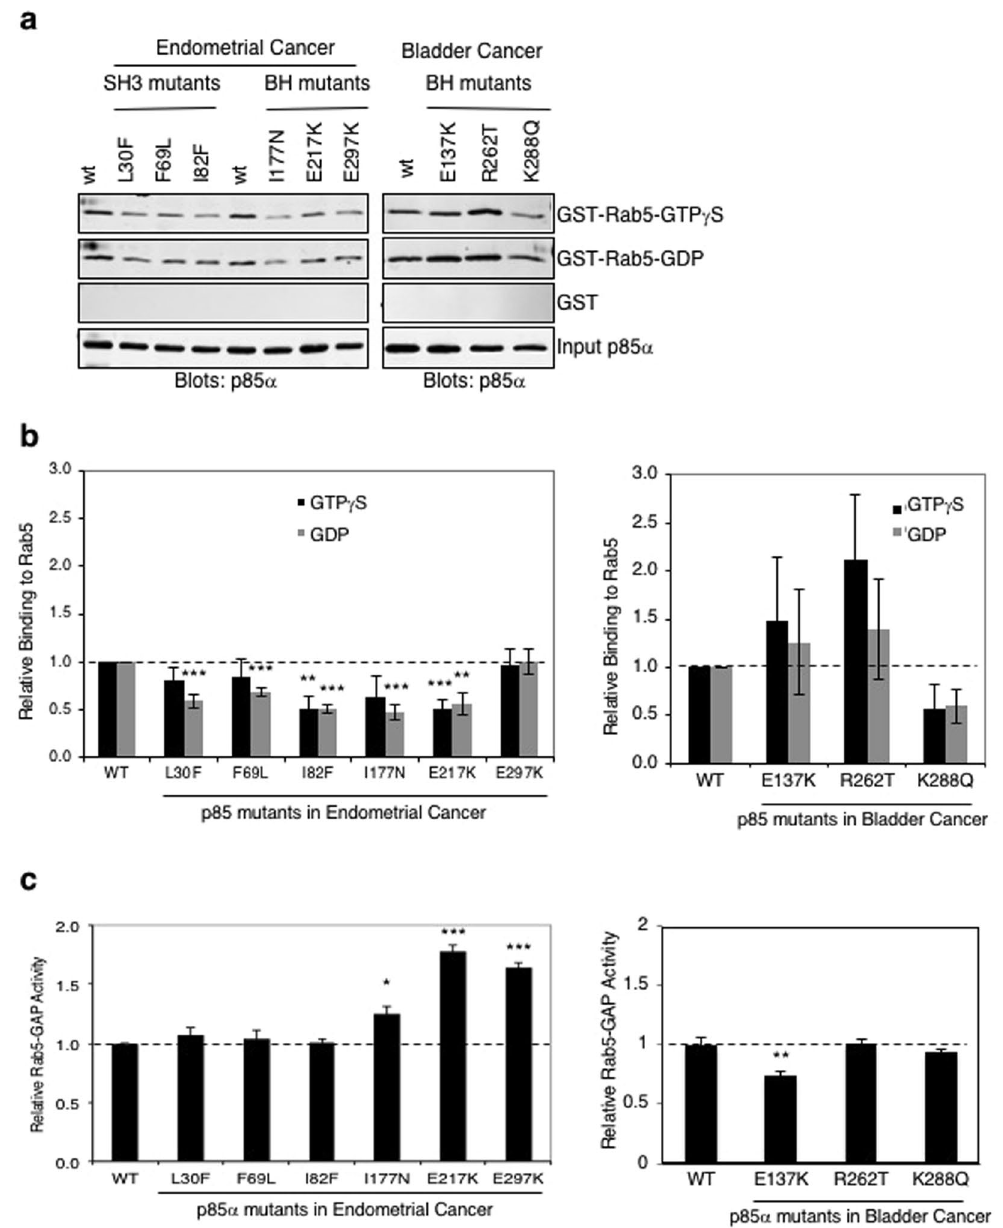
Figure 2. Binding and regulation of Rab5 by p85 α patient-derived SH3 and BH domain mutants. ( a ) Pull- down assay with GST and GST-Rab5 mutants immobilized on glutathione Sepharose beads and loaded with the indicated nucleotide. GTP γ S is a non-hydrolyzable analogue of GTP. Binding of purified p85 α wild type or mutant protein was detected using an immunoblot analysis. Input of p85 α is 4% of the amount used in the pull-down binding experiments. Data representative of at least 4 independent experiments. Full-length images of the cropped blots are in Supplementary Fig. S5. ( b ) Quantification of binding assay results from panel a. Mean ± SEM. *** P < 0.001, ** P < 0.01 as compared to wild type p85 α . ( c ) Rab5 was loaded with [ α - 32 P]-GTP and analyzed for its GTPase activity either alone (no p85 α ) or in the presence of the indicated p85 α protein to measure Rab5 GAP activity. Mean ± SEM for 3 independent experiments. *** P < 0.001, ** P < 0.01, * P < 0.05 as compared to wild type p85 α